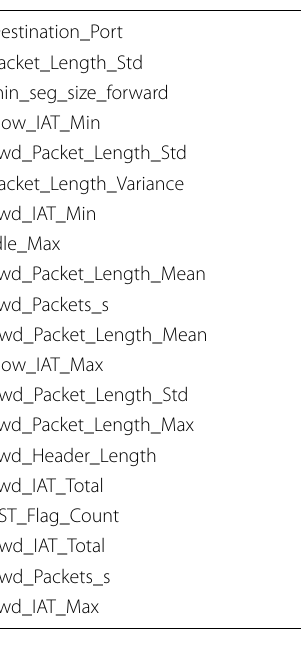
Table 8 Top 20 CSE-CIC-IDS2018 features by supervised ranking technique